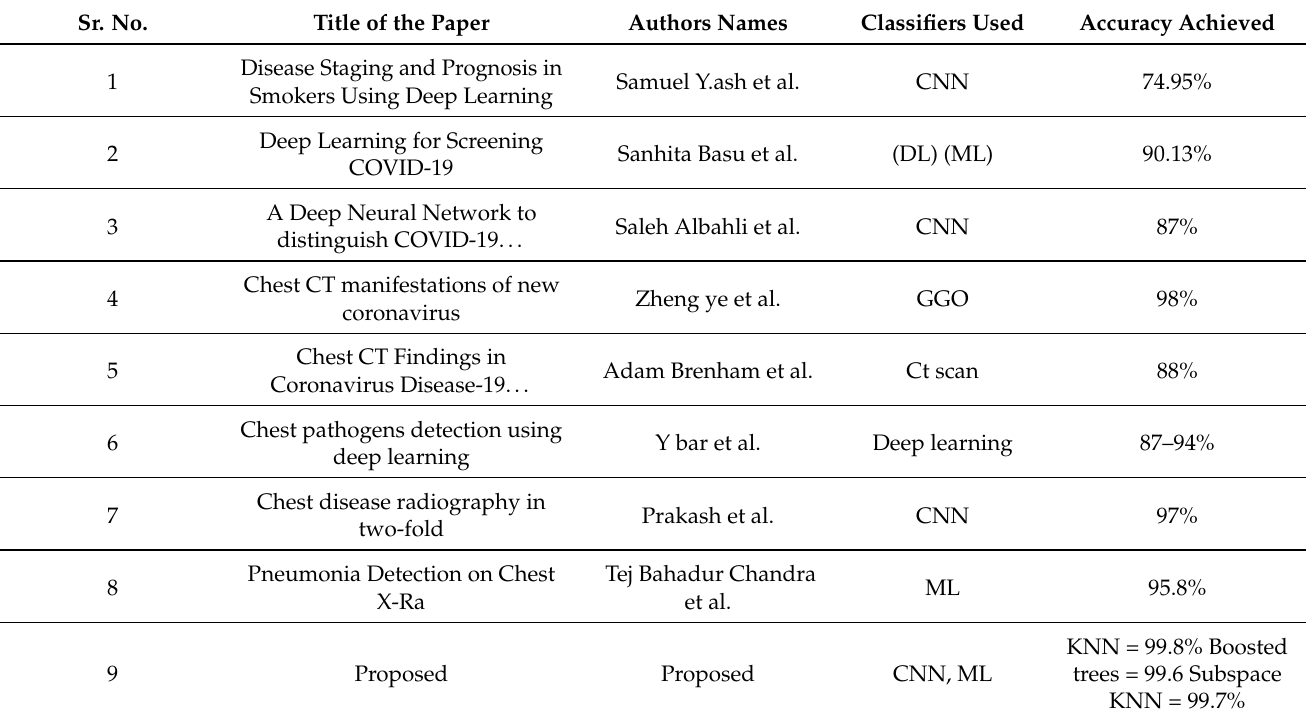
Table 10. Existing method